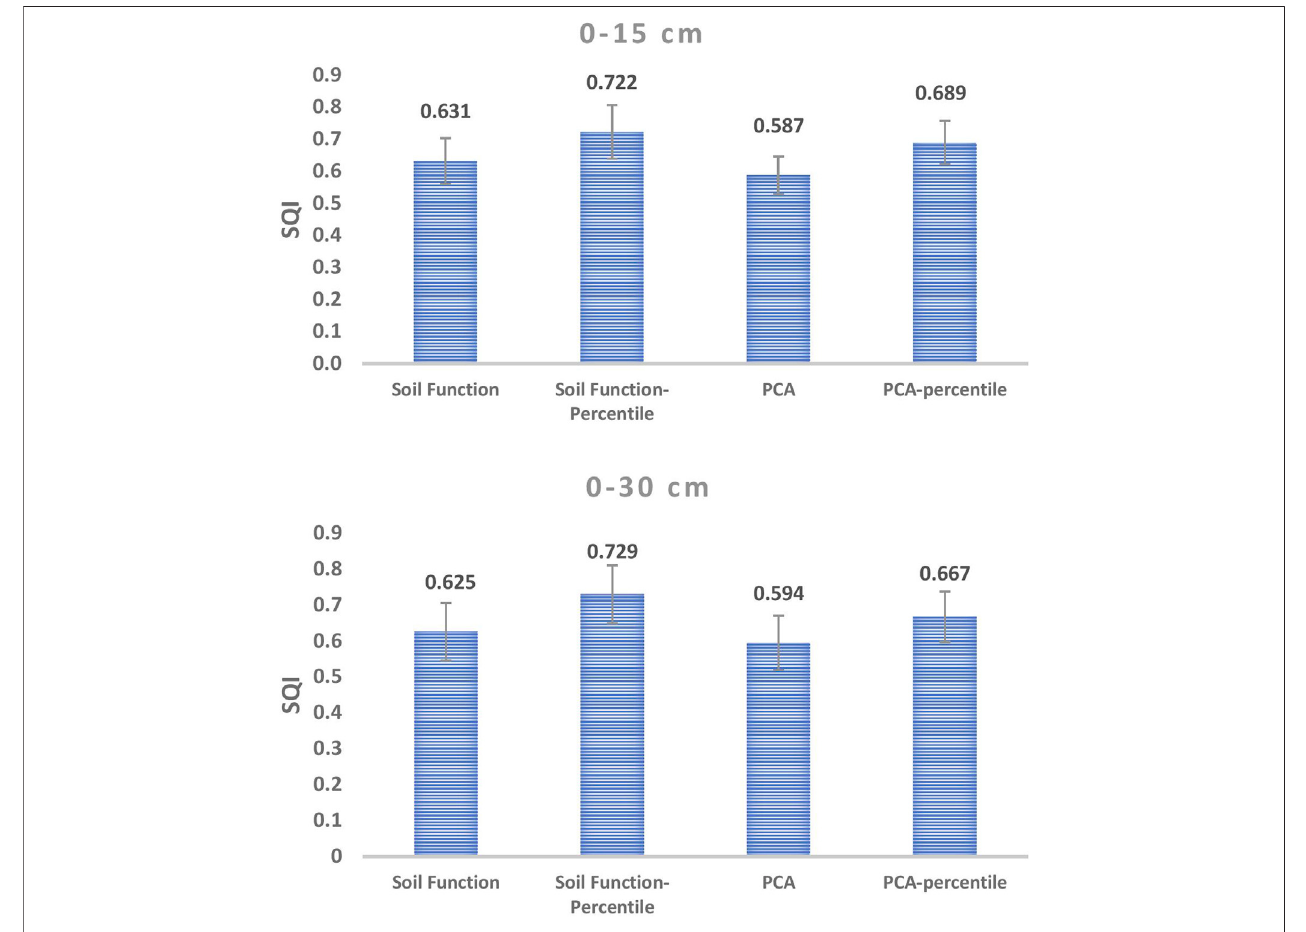
FIGURE 1 | Soil quality index (SQI) of 0 – 15 cm and 0 – 30 cm soil under four indexing procedures ( n = 156). Error bars indicate standard deviation.